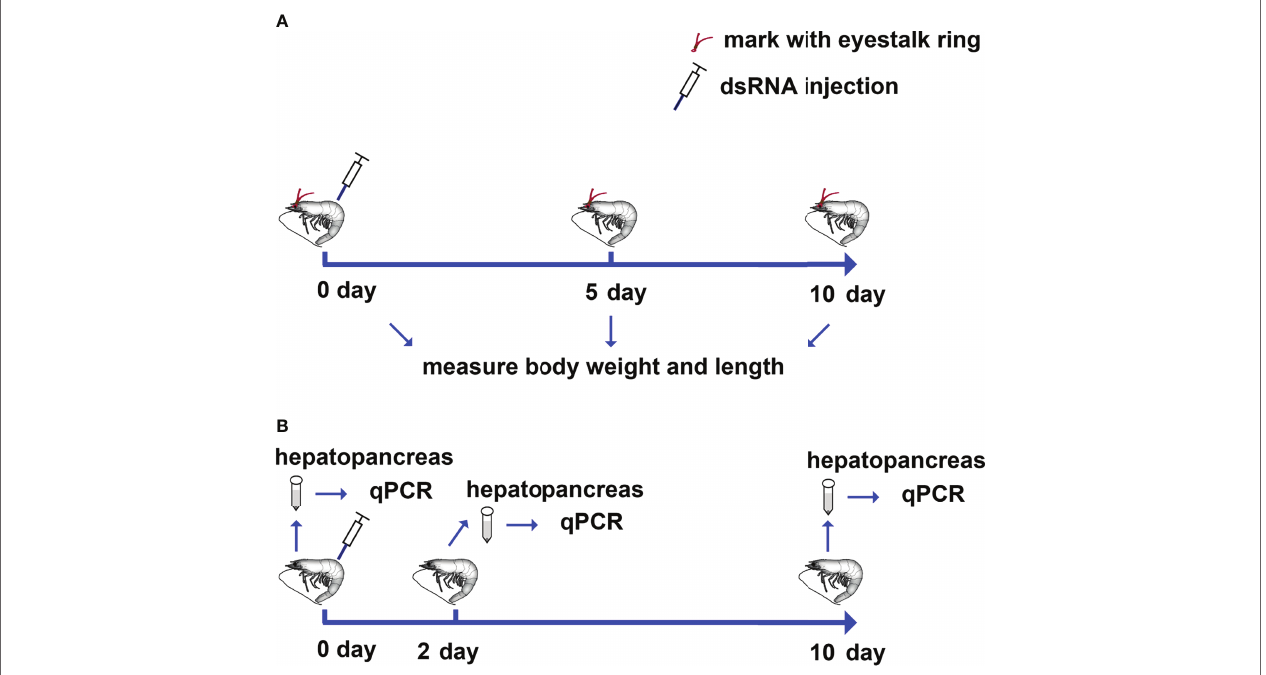
FIGURE 3 | Schematic representation of the procedures for investigating the role of LvRap2a on the growth of shrimp. (A) Each shrimp was marked with a specific eyestalk ring and received dsRNA-LvRap2a or dsRNA-GFP (as control) injections on day 0. Each shrimp’s weight and length were measured on day 0, day 5, and day 10 following dsRNA injection. (B) Shrimp were injected with dsRNA-LvRap2a or dsRNA-GFP (as a control). On day 0, day 2 and day 10 post dsRNA injection, the hepatopancreases of each group (3 shrimp per sample, 3 samples) were collected for total RNA extraction and further qPCR